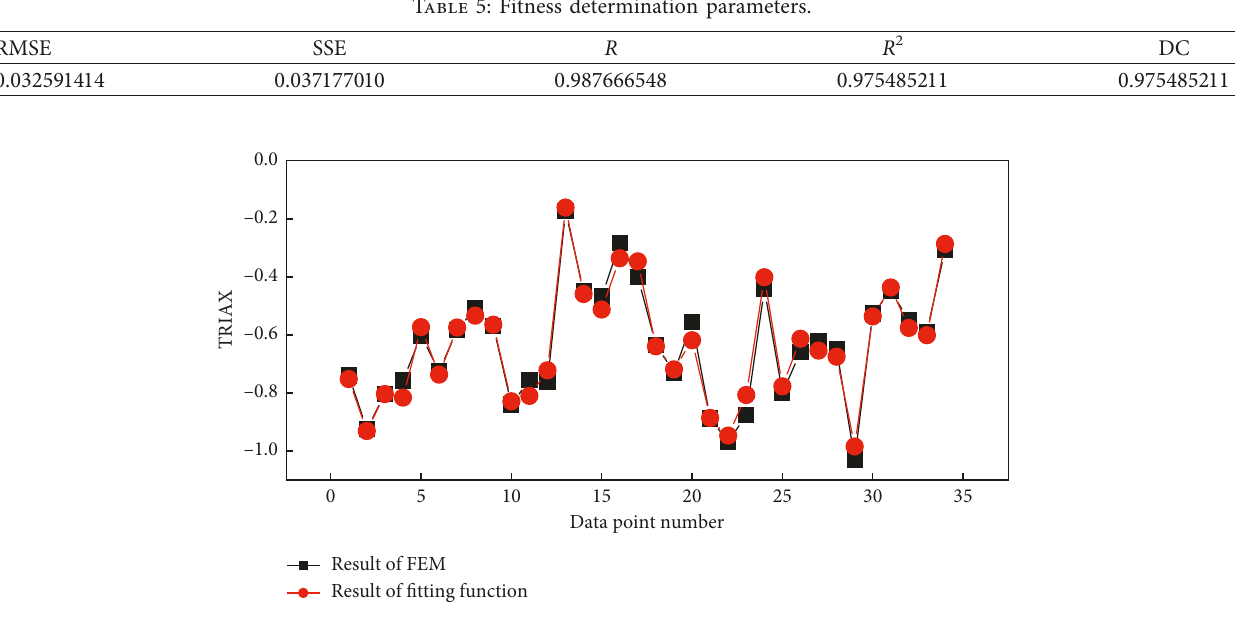
Figure 12: Comparison of the measured values of the average stress triaxiality and the calculated values of the fitting function.